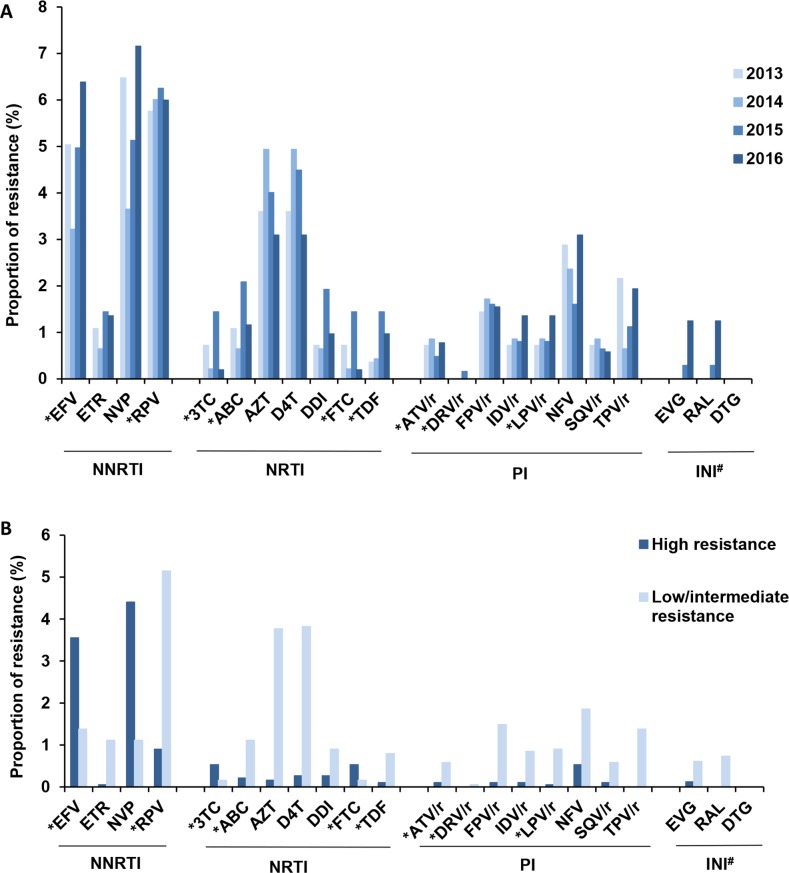
Prevalence of predicted resistance to approved HIV therapeutics according to the Stanford HIVdb.(A) Resistance (low/intermediate/high level) stratified according to the year of diagnosis. (B) Resistance level; # calculated from 820 cases;* drugs included in recommended and alternative first-line treatment option according to EACS 9.0 guidelines; EFV efavirenz, ETR etravirine, NVP nevirapine, RPV rilpivirine, 3TC lamivudine, ABC abacavir, AZT zidovudine, D4T stavudine, DDI didanosine, FTC emtricitabine, TDF tenofovir, ATV atazanavir, DRV darunavir, FPV fosamprenavir, IDV indinavir, LPV lopinavir, NFV nelfinavir, SQV saquinavir, TPV tipranavir, EVG elvitegravir, RAL raltegravir, DTG dolutegravir.